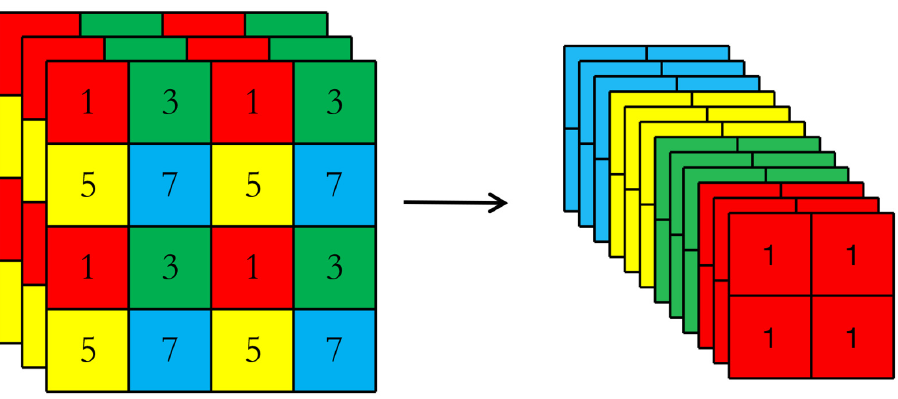
Figure 3. Slicing operation. 4 × 4 × 3 image sliced into 2 × 2 × 12 feature map.